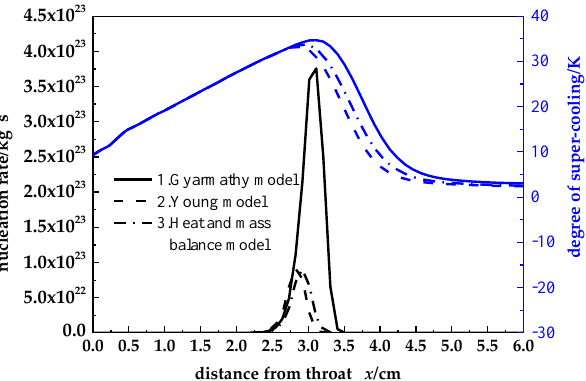
Figure 8. Degree of supercooling and nucleation rate distribution along the nozzle axis.